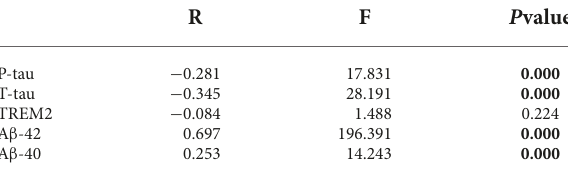
TABLE 2 Correlation between P-tau, T-tau, TREM2, A β -42, A β 40, and preoperative MoCA values.